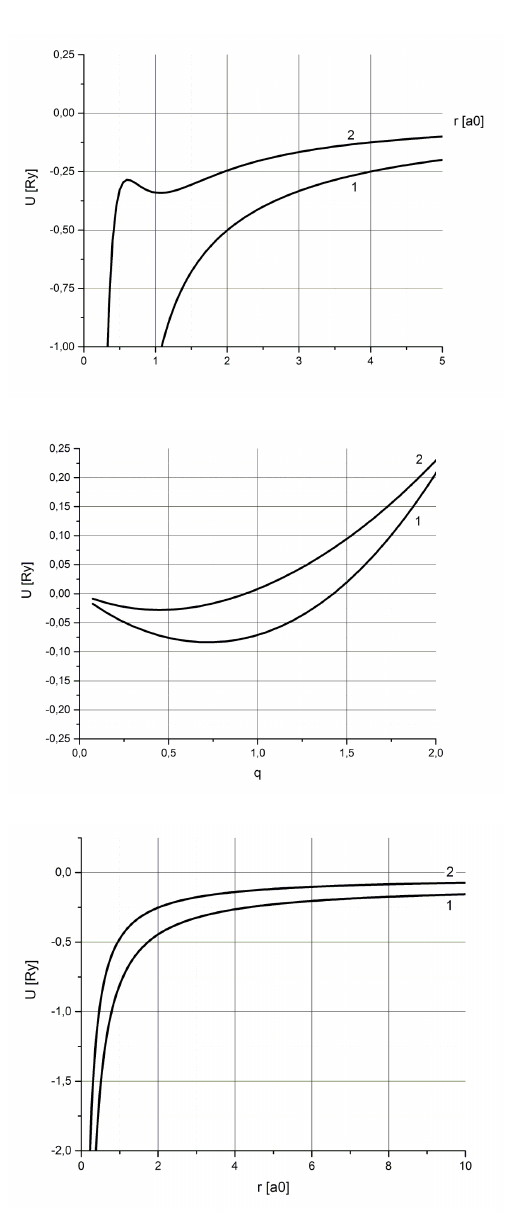
Table 1. Calculated values for charge and minimal energy